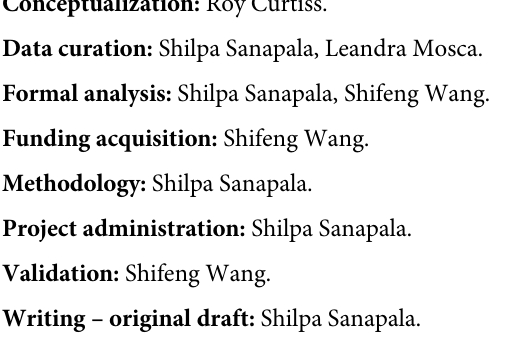
S3 Fig. IL-4 and IL-12 secretion following APC-mediated T-cell activation. T-lymphocytes obtained from BALB/c mice ( n = 5) orally immunized with UK-1( Δ aroA ), 14028S( Δ aroA ) or BSG (mock) were co-incubated with respective UV-inactivated UK-1 or 14028S-infected and mitomycin C—treated APCs. APCs treated with an unrelated antigen, HEL, were also included for comparison. The co-cultures were incubated for 72 h and supernatants were col- lected for determination of (A) IL-4, and (B) IL-12. (TIFF) S4 Fig. Colonization with UK-1 and 14028S. BALB/c mice were orally challenged with 1 x 10 9 CFU of UK-1(Nal r ) or 14028S(Cm r Tc r ). Groups of mice (n = 5 per group) were eutha- nized on days 3 and 6 post challenge. (A) Spleen, (B) liver, (C) Peyer’s patches, (D) MLN, (E) ileum, and (F) cecum were collected to determine the bacterial burdens. No statistically signifi- cant difference was observed between challenge groups. (TIFF) S5 Fig. Colonization with UK-1( Δ aroA ) and 14028S( Δ aroA ). BALB/c mice were orally immunized with 1 x 10 9 CFU UK-1( Δ aroA ) or 14028S( Δ aroA ). Groups of mice (n = 5 per group) were euthanized on days 3 and 6 post challenge. (A) Spleen, (B) liver, (C) Peyer’s patches, (D) MLN, (E) ileum, and (F) cecum were collected for enumeration of bacteria.